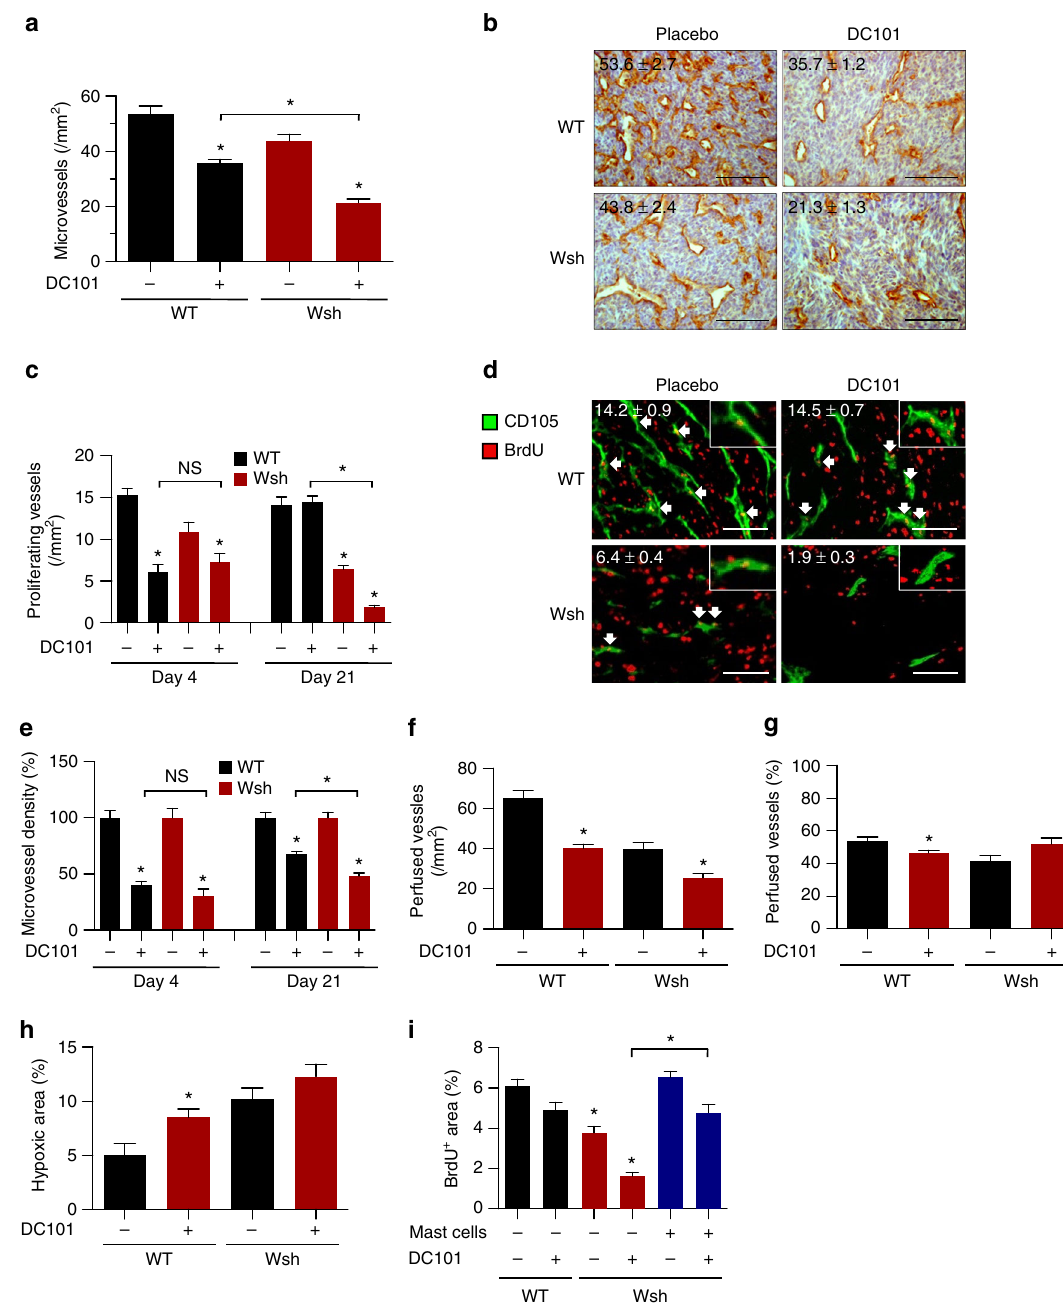
Fig. 2 Mast cell-de fi ciency and AAT induce additive anti-angiogenic effects by reducing endothelial cell proliferation without affecting vessel functionality. a Histomorphometric quanti fi cation of CD31 + microvessels in Panc02 tumor sections. Results are shown for C57Bl/6J (WT) and MC-de fi cient (Wsh) mice treated with placebo or 20 mg/kg DC101 ( n = 8/8/5/5; * p < 0.05; one-way ANOVA). b Representative images of CD31 + tumor sections are displayed and their quanti fi cation is shown in each panel. Scale bar represents 100 µ m. c – e Histomorphometric quanti fi cation of BrdU + CD105 + proliferating ( c ) and CD31 + total ( e ) tumor microvessels ( n = 7/7/6/6; * p < 0.05; one-way ANOVA). d Representative images of BrdU + CD105 + tumor sections. Arrows indicate examples of proliferating microvessels and their quanti fi cation is shown in each panel. Inlets show details of proliferating endothelial cells. Scale bar represents 100 µ m. Results are shown for C57Bl/6J (WT) and MC-de fi cient (Wsh) mice transplanted with Panc02 tumors that were treated for 4 or 21 days with placebo or 20 mg/kg DC101. f , g Histomorphometric quanti fi cation of CD31 + FITC-Lectin + microvessels in Panc02 tumor sections displayed as absolute ( f ) or relative ( g ) values ( n = 8/8/5/5; * p < 0.05; one-way ANOVA). h Histomorphometric quanti fi cation of Pimonidazole + hypoxic areas from Panc02 tumor sections. Results are shown for C57Bl/6J (WT) and MC-de fi cient (Wsh) mice treated with placebo or 20 mg/kg DC101 ( n = 6/7/4/4; * p < 0.05; one-way ANOVA). i Histomorphometric quanti fi cation of BrdU + area from Panc02 tumor sections. Panc02 tumor cells were transplanted alone or in combination with BMMC into the fl anks of C57Bl/6J (WT) or MC-de fi cient (Wsh) mice. After randomization animals received treatment with placebo or 20 mg/kg DC101 ( n = 9/9/7/6/7/5; * p < 0.05; one-way ANOVA). Results are shown as representative means ±